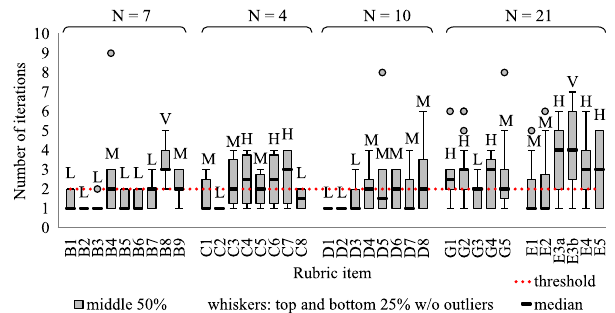
FIG. 5. The number of iterations needed before a report in the rubrics period received a full score on a particular rubric item represented as a box-and-whiskers type diagram. The difficulty levels are determined as described in the text. The threshold is indicated by the dotted